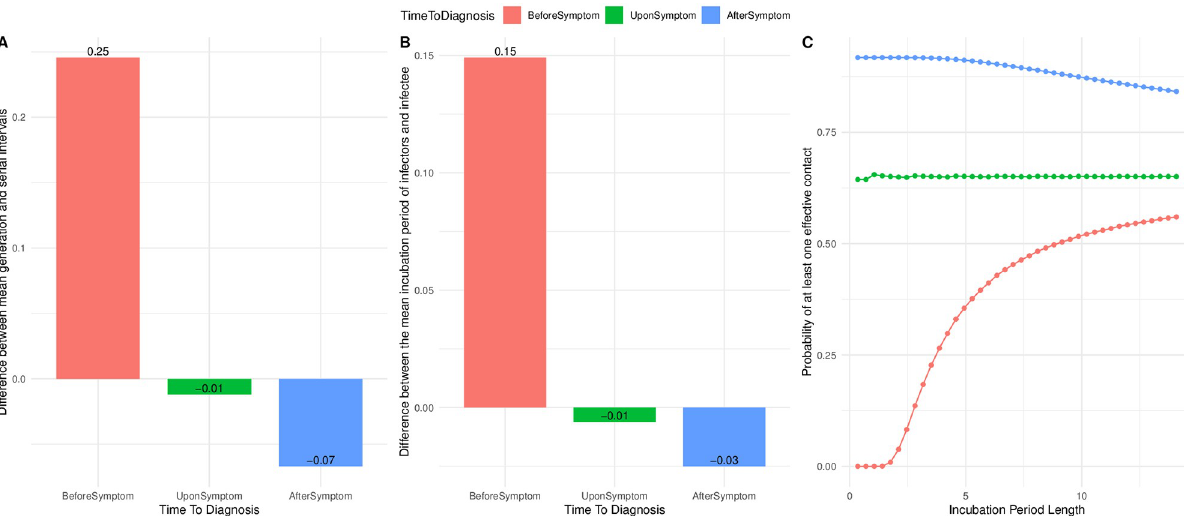
Fig 4. Difference between mean serial and generation intervals and realized incubation periods. (A) Difference between mean serial and generation interval and (B) between the realized incubation period of infectors and infectee when the time to diagnosis varies among: 1 day before symptom onset (BeforeSymptom), at symptom onset (UponSymptom), after a gamma-delay from symptom onset (AfterSymptom). (C) Probability that infectious individuals make at least one effective contact during their infectious period, for a varying incubation period length.